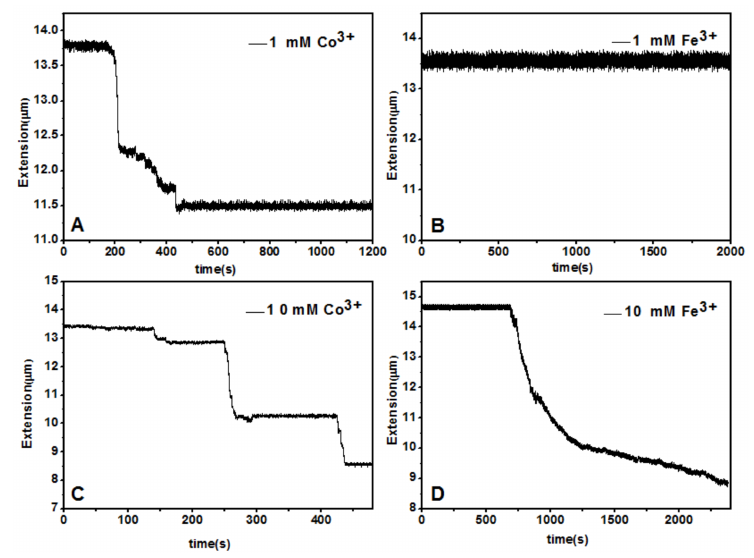
Figure 9. DNA extension-time curves at concentrations of Fe 3+ ( b , d ) and Co 3+ ( a , c